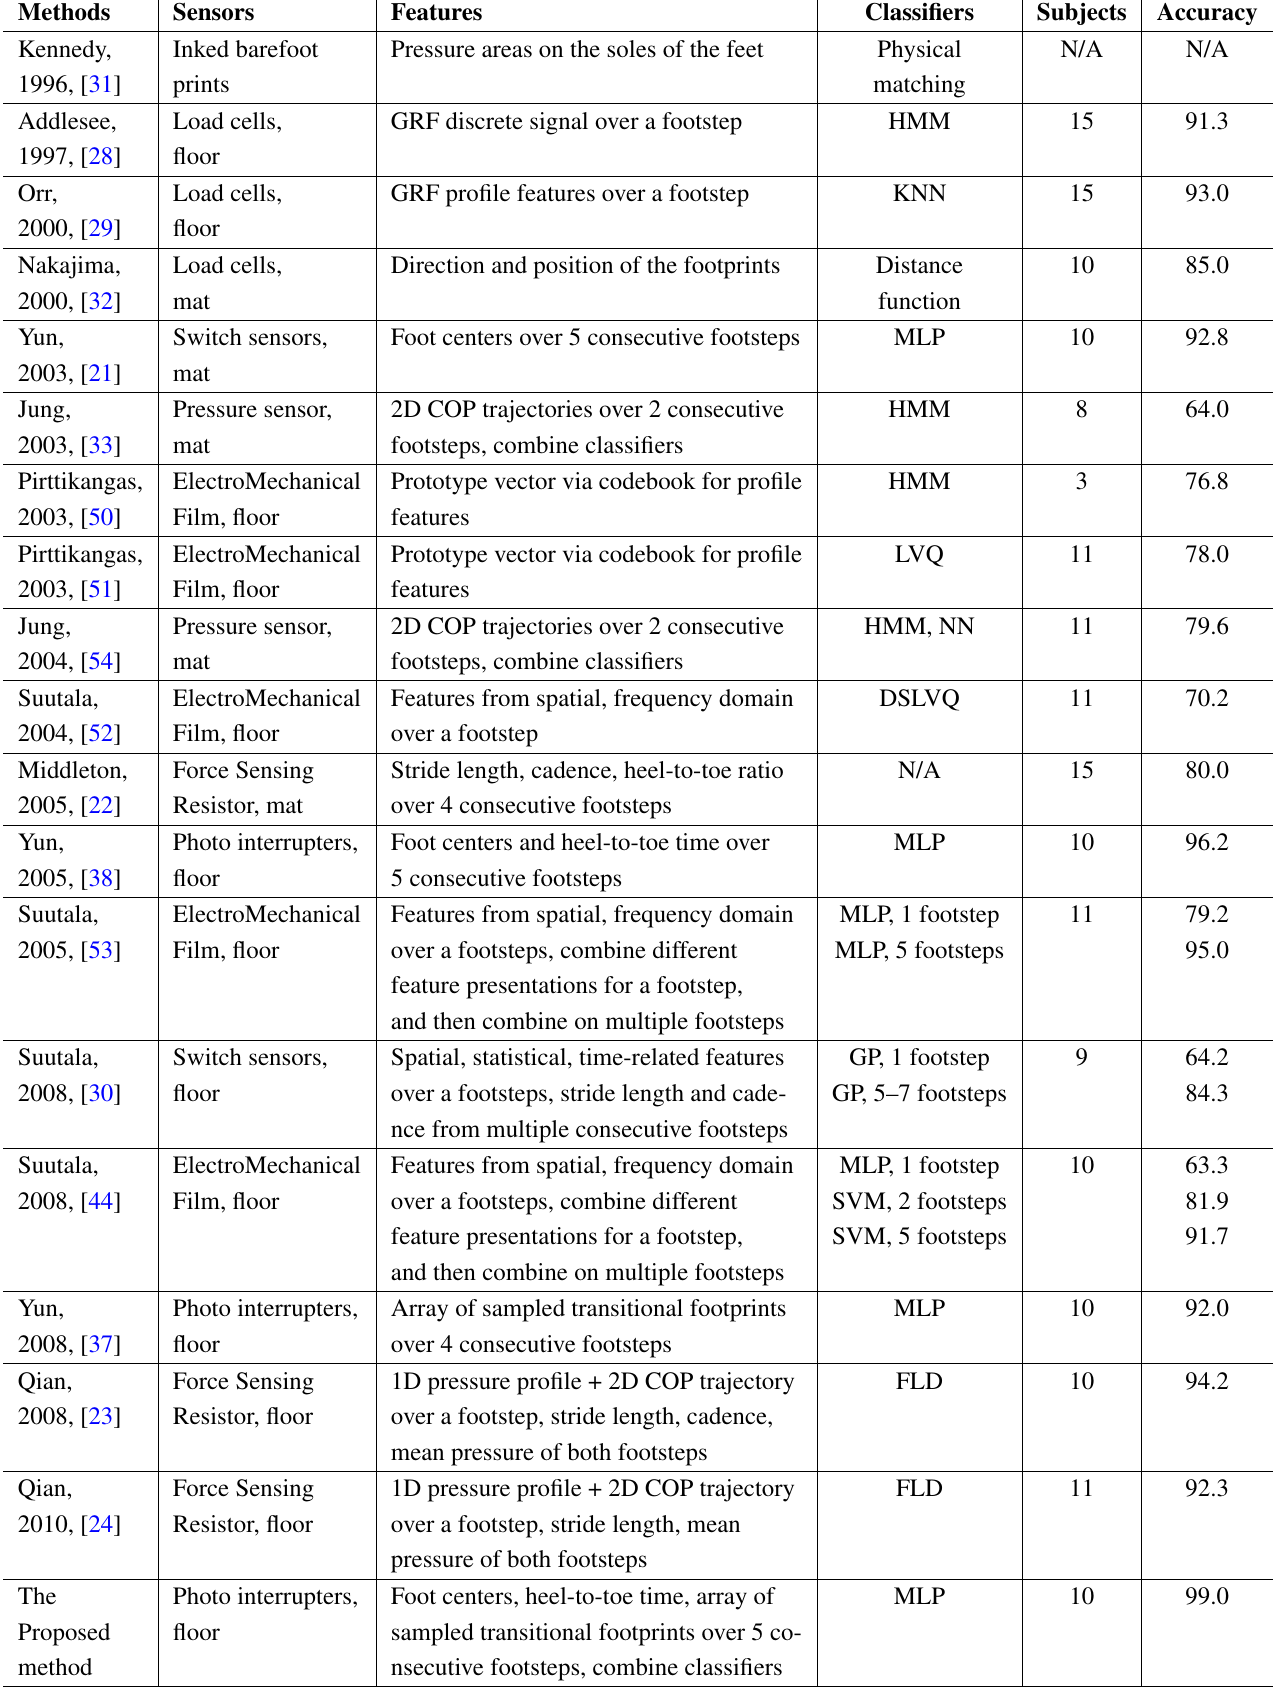
Table 11. Performance comparison of all floor-based